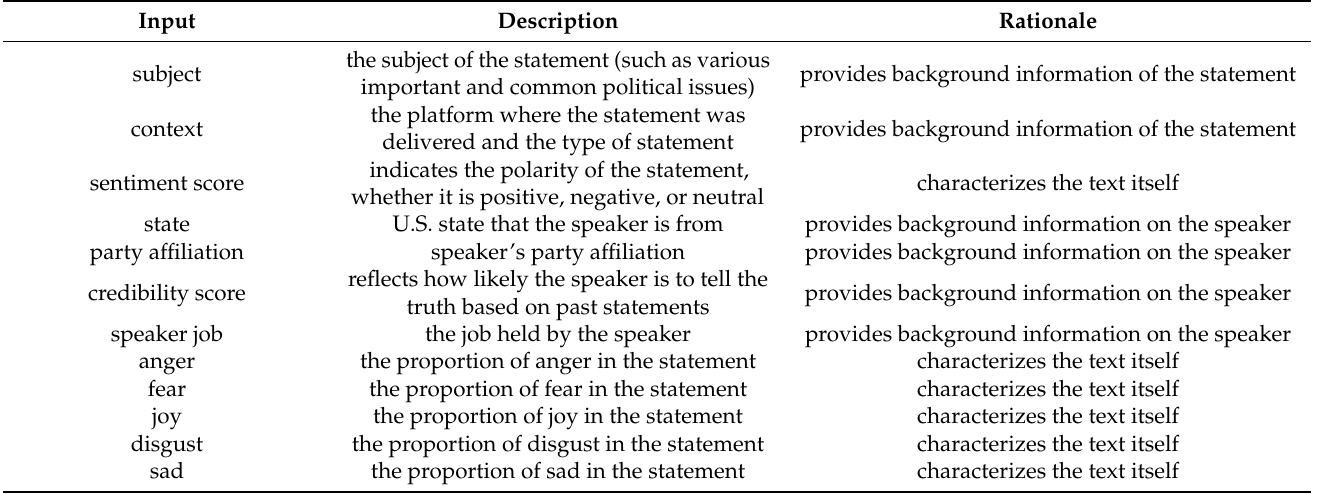
Table 1. Network Inputs (input names are from the Sentimental LIAR dataset